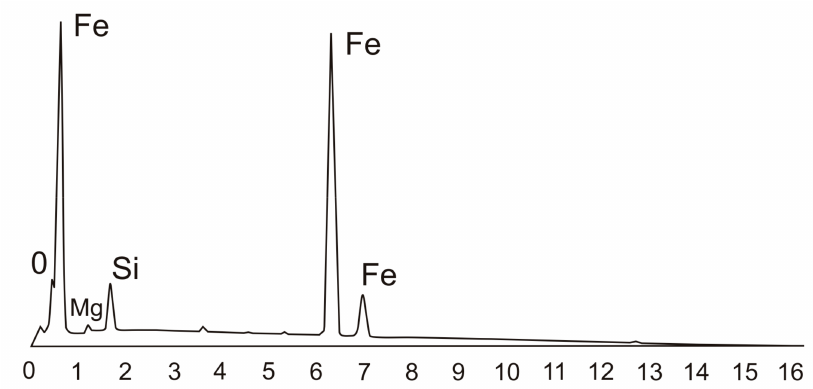
Figure 6. EDS point analysis of inclusion present in Figure 4